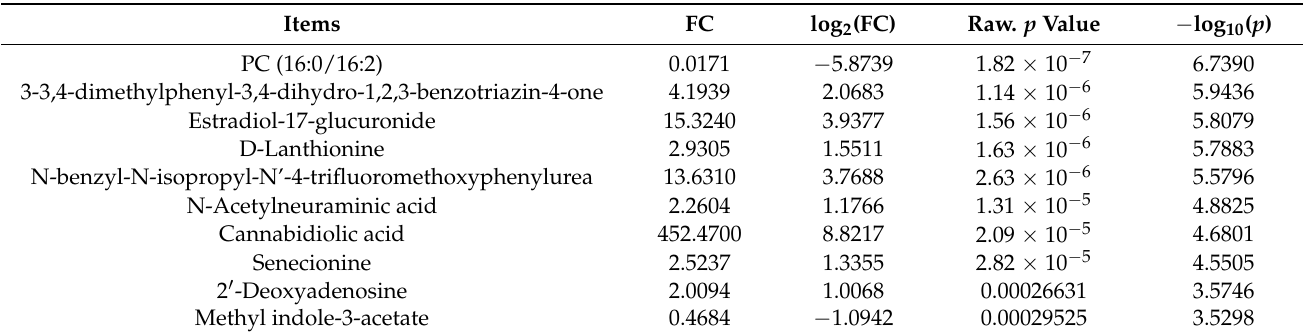
Table 5. Top 10 differential yolk metabolites identified between male and female chicken embryos at E19.